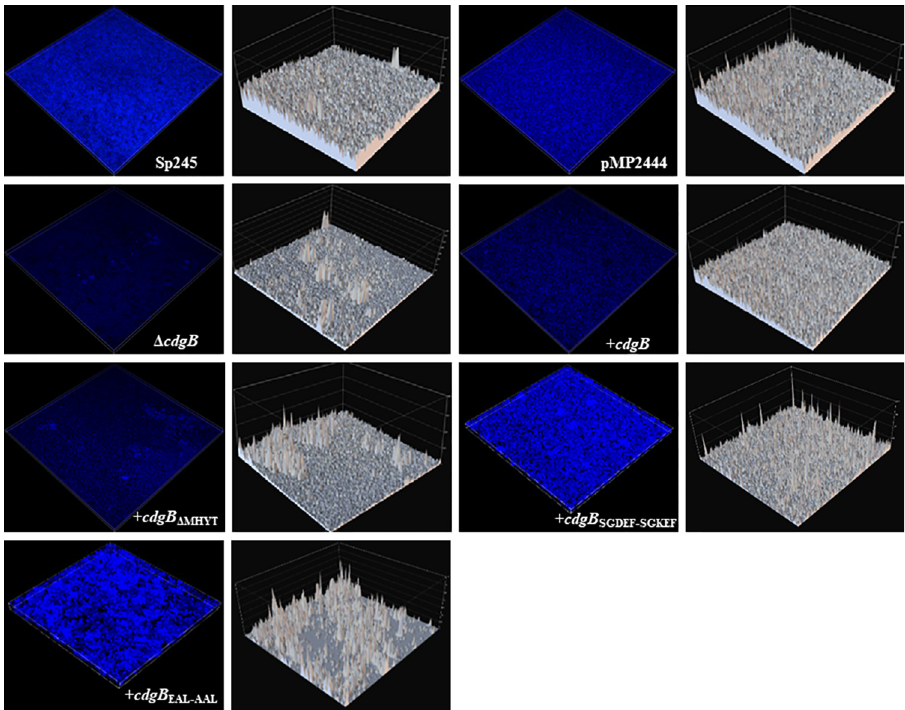
Fig 6. Biofilm formation analysis with confocal laser scanner microscopy. Images represent Three-dimensional reconstruction of 5-day old static biofilms; the blue fluorescence signal represents exopolysaccharides staining. Gray images are Intensity surface plots corresponding to the emitted fluorescence by CWC. The biofilm formed was directly observed using Nikon confocal microcopy C2+ with a 20X objective (CFI Plan ApVC 20X numerical aperture of 1.2). Exciting laser intensity, background level contrast, and electronic zoom were maintained at the same